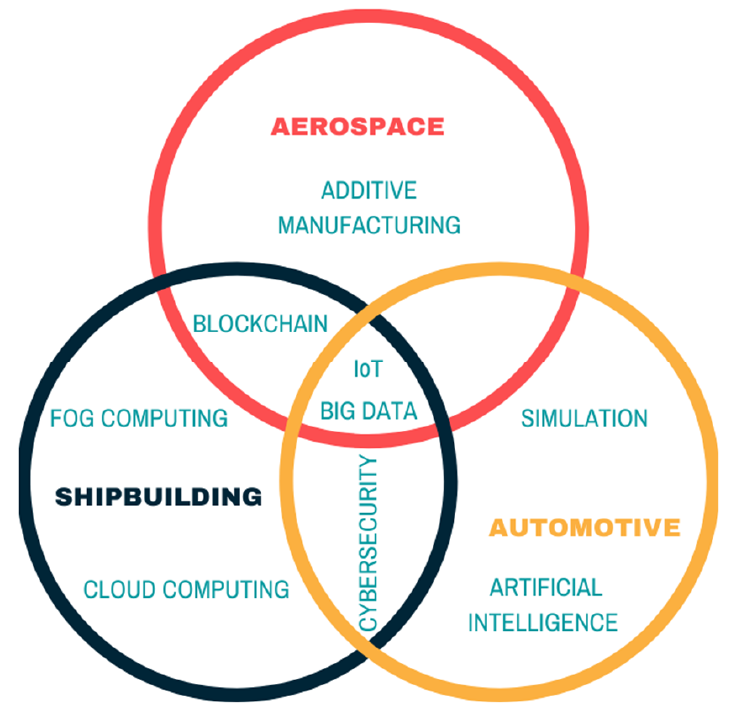
Figure 5. Focus technologies in Supply Chain Management (SCM) digitalization.